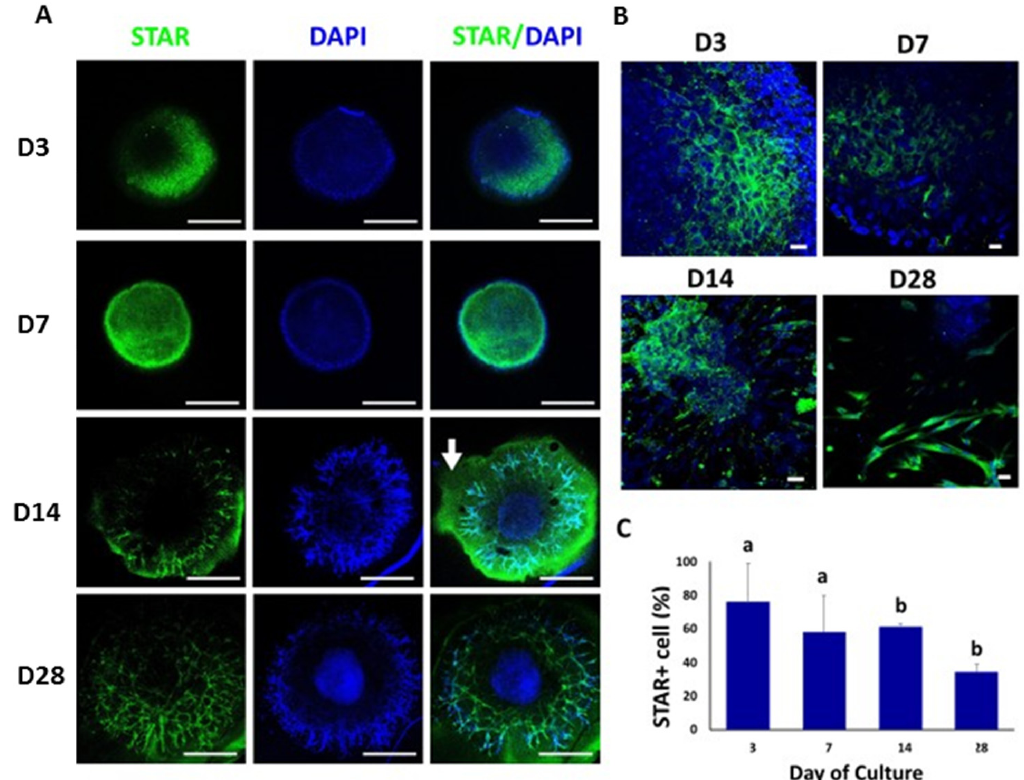
Figure 4. Confocal immunofluorescence analysis of STAR expression in whole mounted bovine TOs. ( A , B ) Immunofluorescence associated with STAR in whole TOs ( A ) and branched areas of TOs ( B ). ( C ) The percentages of STAR-positive cells on days 14 and 28 were significantly lower compared to days 3 and 7. Data were expressed as the mean ± SEM ( n = 3). Cell nuclei were stained blue with DAPI. Scale bars = 500 μ m ( A ) and 25 μ m ( B ). White arrow = Matrigel area. Superscripts (a,b) indi- cate significant ( p < 0.05) differences in proportions of cells positive for STAR between days of cul- ture.